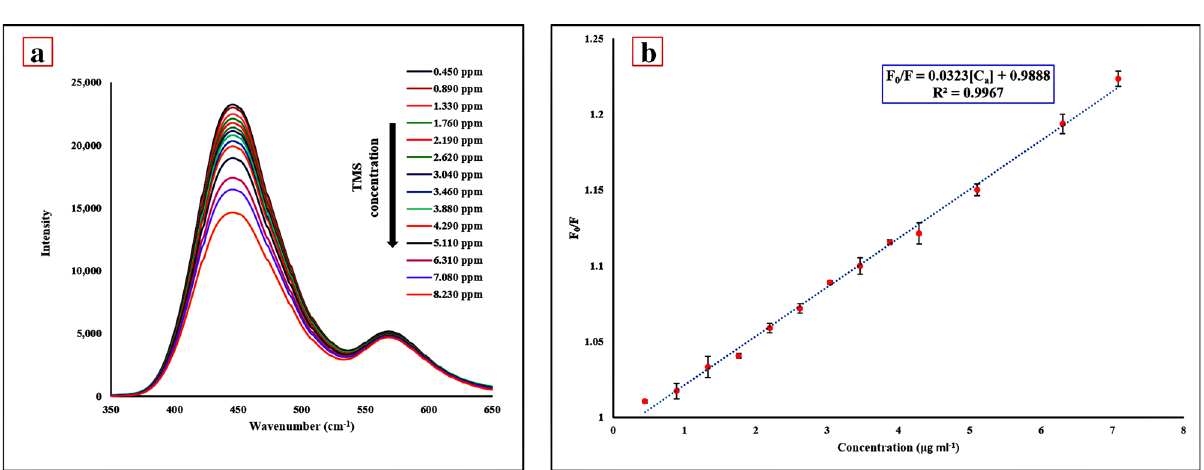
Figure 4. ( a ) FL emission spectra of CQD/RhB sensor in the presence of different concentrations of TMS, and ( b ) linear calibration plot in different concentrations of TMS (pH = 3, volume ratio = 0.2, and time = 15 min). Error bars represent the standard deviation from three